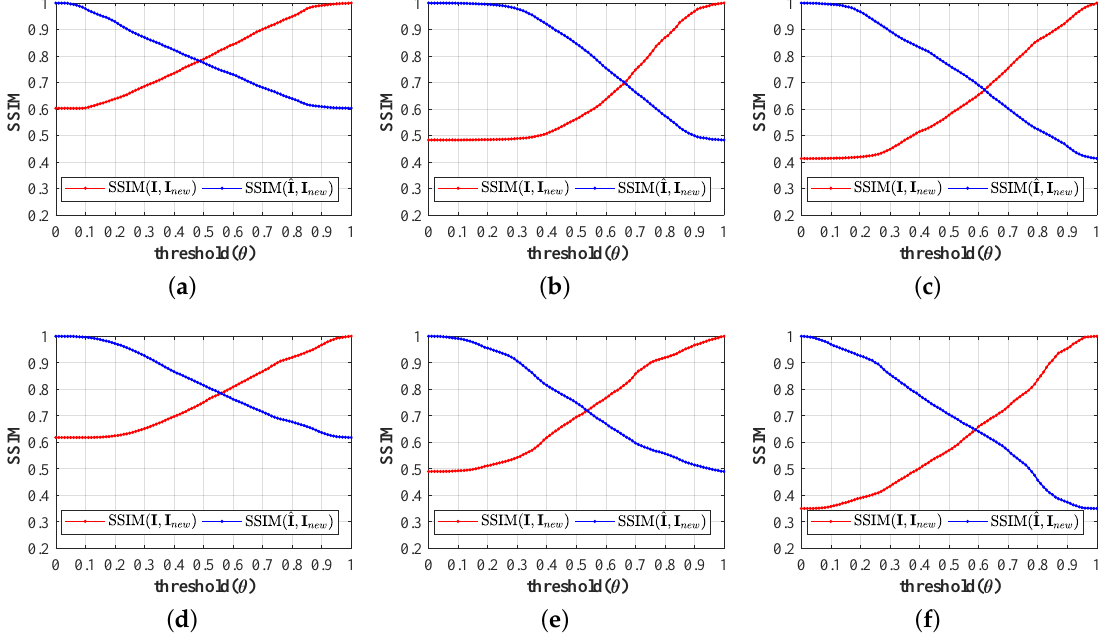
Figure 4. Structural similarity (SSIM) results for each variation ( a ) angry; ( b ) afraid; ( c ) disgusted; ( d ) sad; ( e ) smiling; ( f )